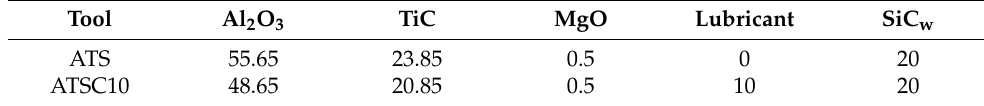
Table 1. Composition of ceramic cutting tool materials (vol.%).